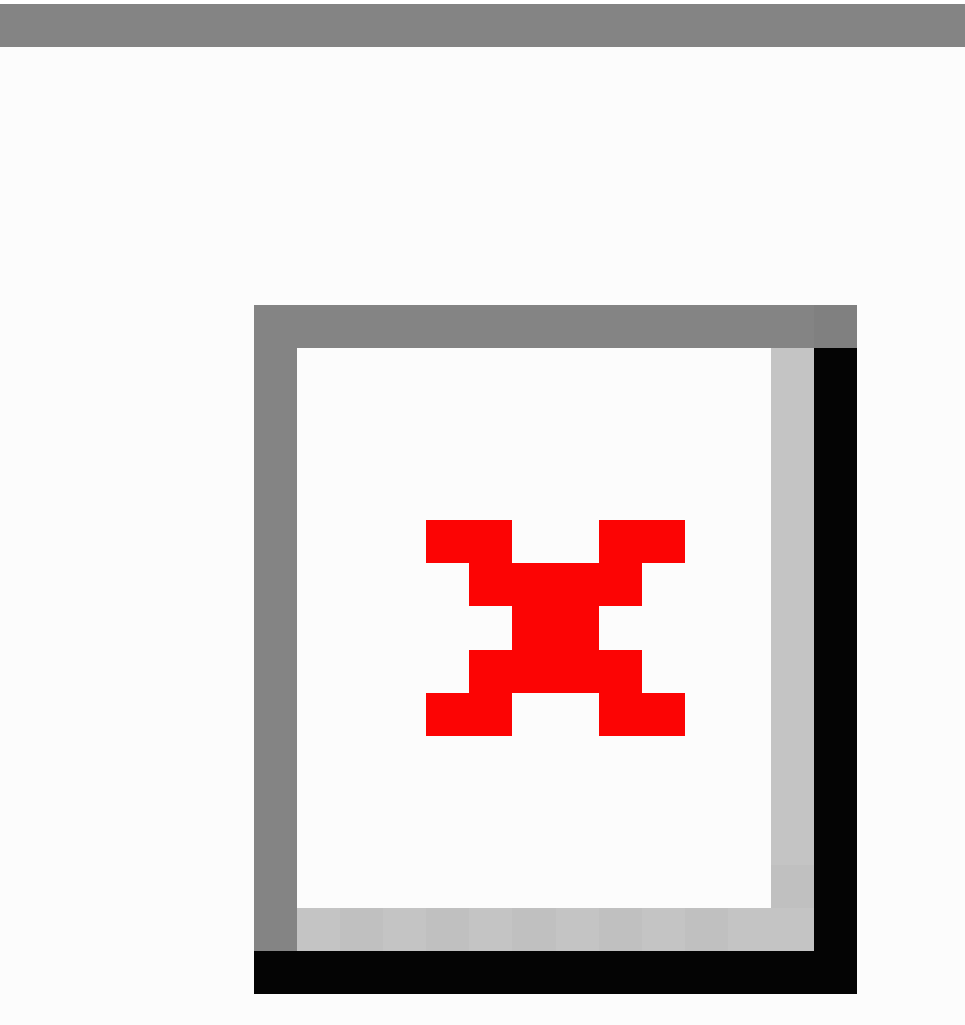
Figure 3. Intervention adherence for the remote and in-person groups. The whiskers represent standard